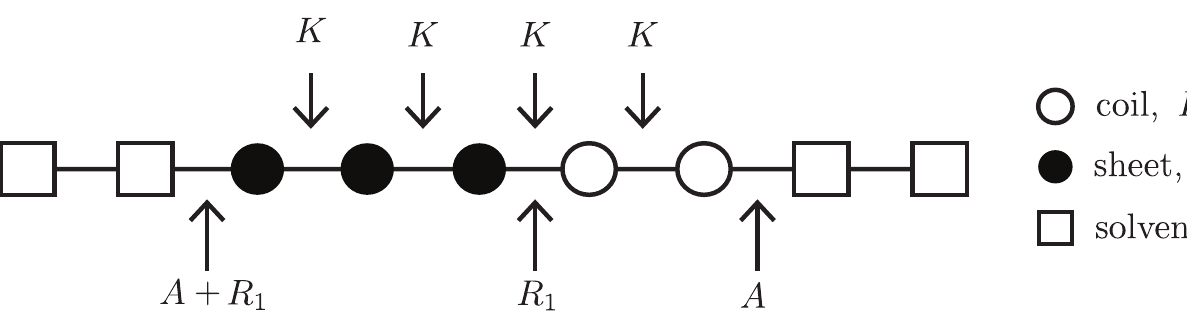
= 1 and the free energies c